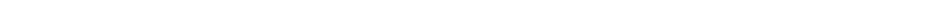
(see fi gure on previous page) Fig. 2 LSD1 – ACE2 interactions and the effect of LSD1 on the spike protein. a Inhibition of ACE2me2 peptide demethylation by LSD1 inhibitors. LSD1 enzyme was incubated with tranylcypromine, GSK, SP2509, or DMSO for 30 min. The LSD1 activity in each sample was measured by a demethylation assay with ACE2me2 peptide. Fluorescence was measured at 40 s intervals on a Synergy H4 multi-mode plate reader. Statistical signi fi cance was calculated using one-way ANOVA, ∗∗∗∗ P < 0.0001. b Structure of ACE2 bound to the SARS-CoV-2 spike domain (PDB 6M17). Binding of ACE2 and the spike domain involves a Lys 31 (ACE2) and Gln 493 (spike) interaction. ACE2 is shown in yellow in cartoon mode, and spike domain in gray. Residues are shown in stick format. Methylation of ACE2 Lys31 (right panel) would disrupt this interaction. c Western blot analysis of ACE2 IP samples. Following ACE2 IP of Caco-2 cell membrane extract lysates, samples were analyzed by SDS-PAGE and blotted for pan-methylation lysine. d Schematic of SARS-CoV-2 infection assays. Caco-2 cells were seeded 24 h before the experiment. Then, cells were treated with each drug component for 48 h followed by SARS-CoV-2 infection (MOI 1.0). After 1 h viral adsorption incubation, the virus inoculum was removed and drug- containing medium was added. Then, cell culture supernatants were harvested at 0, 24, or 48 hpi and infected cells were collected at 48 hpi. Detection of viral genomes in the extracted RNA was performed by qRT-PCR, and viral spike proteins were quanti fi ed by a digital pathology assay (ASI system). e Duolink ® proximity ligation assay measurements of protein interactions were performed on unpermeabilized Caco-2 cells infected with SASR-CoV-2 and treated with control or GSK. The Duolink assay produces a single bright dot per interaction within the cell. Representative images (left) are shown for ACE2 and pan-methylation lysine antibody. PLA signal intensity of the Duolink ® assay (right) is shown for average dot intensity (single Duolink dot) or overall cell intensity for each cell. Data represent n = 20 cells, with signi fi cant differences calculated with the unpaired t -test ( ∗∗∗∗ P < 0.0001). Representative images are shown with 10 µM scale bar in orange. f Duolink ® proximity ligation assay measurements of protein interactions were performed on unpermeabilized Caco-2 cells transfected with VO, ACE2 WT, or ACE2 F31 plasmids and treated with 50 ng of SARS- CoV-2 spike protein. Samples were then probed with antibodies speci fi c for ACE2 and SARS-CoV-2 spike protein. The Duolink assay produces a single bright dot per interaction within the cell. Representative images (left) are shown for ACE2 and SARS-CoV-2 Spike Duolink ® . PLA signal intensity of the Duolink ® assay (right) is shown for average dot intensity (single Duolink dot). Data represent n = 20 cells, with signi fi cant differences calculated with Kruskal – Wallis ANOVA ( ∗∗∗∗ P < 0.0001). Representative images are shown with 10 µM scale bar in orange. g Dot plot quanti fi cation of the fl uorescence intensity (cell surface) of SARS-CoV-2 spike protein in SARS-CoV-2-infected Caco-2 cells with phenelzine or GSK treatment. >50 cells were analyzed for each group and were quanti fi ed using the digital pathology assay (ASI system). Mann – Whitney test: ∗ P < 0.05, ∗∗∗∗ P < 0.0001 denote signi fi cant differences. h Principal component analysis (PCA) depicting transcriptional pro fi les for control, GSK, and phenelzine groups after batch effect removal. Experimental batches represented by different shapes (circles, batch 1; triangles, batch 2). i Heatmap of DEGs belonging to Reactome pathways: R-HSA-913531 interferon signaling (left); MAPK signaling-related pathways (R-HSA-5683057 MAPK family signaling cascades, R-HSA- 5673001 RAF/MAP kinase cascade, and R-HSA-5684996 MAPK1/MAPK3 signaling; middle); and translation related pathways (R-HSA-70614 amino acid synthesis and interconversion (transamination), R-HSA-8957275 post-translational protein phosphorylation; right). The heatmap values depict the log 2 -fold change (logFC) of DEGs from treated cells compared with control cells (GSK vs. control and phenelzine vs. control). j Dot plot visualization of the top enriched Reactome pathways in treated cells compared to control cells. The dot color represents the false discovery rate (FDR) value for each enriched Reactome pathway and size represents the gene ratio. k Structure of ACE2 bound to the SARS-CoV-2 spike protein as depicted in a . Also depicted are the two peptide inhibitors targeting this region (ACE2-01, ACE2-02) and the interaction with the SARS-CoV-2 spike protein. l Schematic of SARS-CoV-2 infection. Caco-2 cells were seeded for 24 h and then infected with SARS-CoV-2 at MOI 1.0 in the presence of ACE2 peptide inhibitors (ACE2-01 or ACE2-02) for 1 h. The virus inoculum was removed and inhibitor-containing medium was added. Then, cell culture supernatants were collected at 0 or 48 hpi and infected cells were harvested at 48 hpi. Antiviral activity was assessed with three viral assays: SARS-CoV-2 qRT-PCR, median tissue culture infective dose assay (TCID 50 ), and viral SPIKE protein quanti fi ed by digital pathology (ASI system). m Cell proliferation analysis of Caco-2 control and ACE2-01/ACE2-02-treated cells over a 96-h period. Proliferation was analyzed using WST-1 reagent and absorbance read after 2 h incubation. The graph depicts relative cell proliferation from three replicates expressed as a percentage of control cells (untreated, 0 h). Statistical signi fi cance was calculated using one-way ANOVA at each time point. n qRT-PCR analysis to detect replicates of SARS-CoV-2 RNA in Caco-2 culture supernatants and infected cells at the indicated time points post-infection. Relative infection was normalized to the uninfected control. Data represent mean ± SEM, n = 3. One-way ANOVA, ∗∗∗∗ P < 0.0001 denotes signi fi cant differences. o TCID 50 assay to measure infectious viral titers in the culture supernatants of infected cells. Data represent mean ± SEM, n = 3. One-way ANOVA, ∗∗ P < 0.01 denotes signi fi cant differences. p Dot plot quanti fi cation of the fl uorescence intensity (cell surface) of SARS-CoV-2 spike and ACE2 in SARS-CoV-2-infected Caco-2 cells with ACE2-01 or ACE2-02 treatment. >50 cells were analyzed in each group and were quanti fi ed by digital pathology (ASI system). The PCC was calculated for colocalization ( n = 20 cells were analyzed). Mann – Whitney test: ∗∗∗∗ P < 0.0001 denote signi fi cant differences. q Duolink ® proximity ligation assay measurements of protein interactions were performed on unpermeabilized Caco-2 cells infected with SARS-CoV-2 and treated with control, GSK, or ACE2-01 or ACE2- 01 peptide inhibitors. The Duolink assay produces a single bright dot per interaction within the cell. Representative images (left) are shown for ACE2 and SARS-CoV-2 Spike Duolink ® . PLA signal intensity of the Duolink ® assay (right) is shown for average dot intensity (single Duolink dot). Data represent n = 20 cells, with signi fi cant differences calculated with Kruskal – Wallis ANOVA ( ∗ P < 0.05, ∗∗∗∗ P < 0.0001). Representative images are shown with 10 µM scale bar in